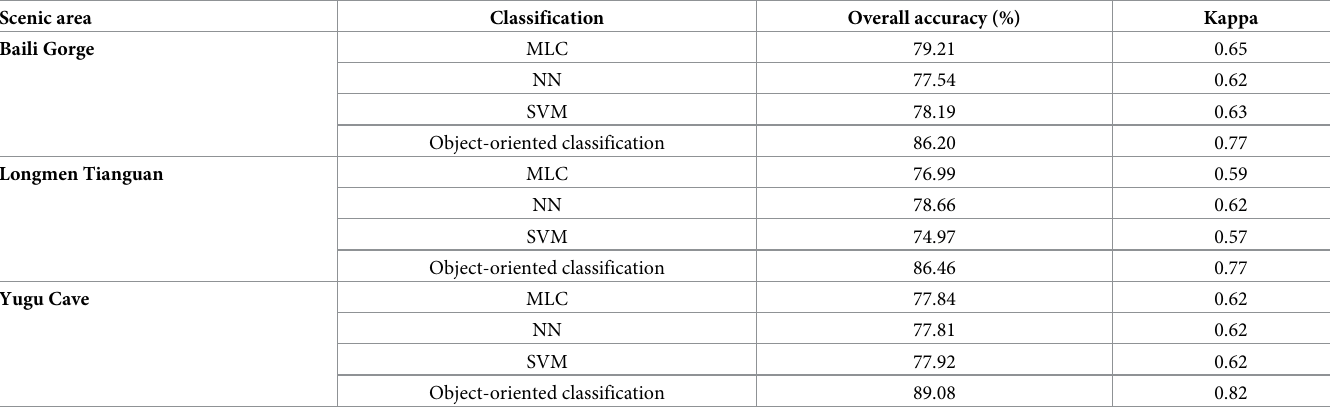
Table 9. Accuracy evaluation of pixel-based and object-oriented classifications. Scenic area